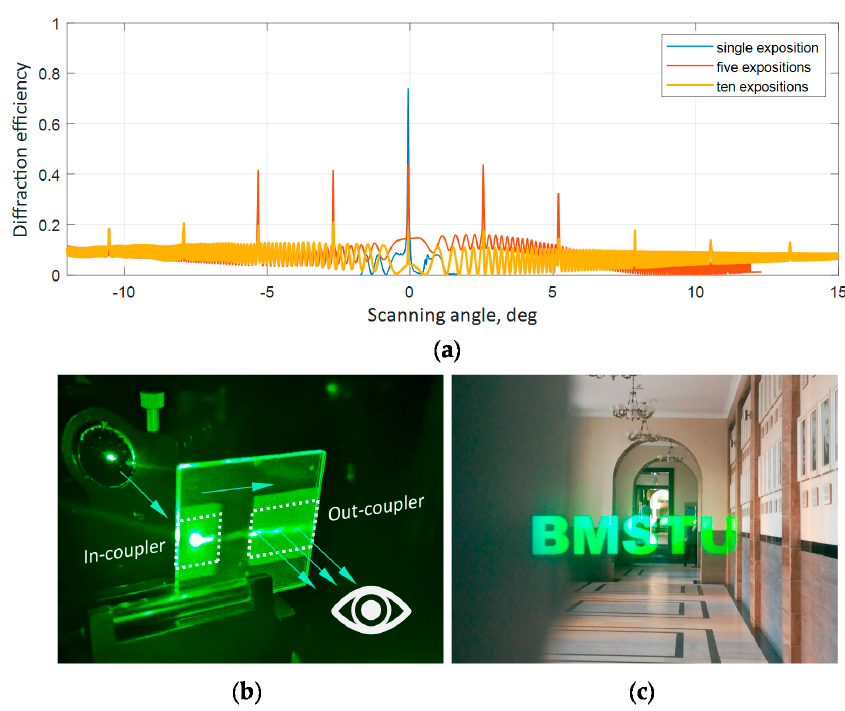
Figure 5. ( a ) Diffraction efficiency via scanning angle recorded with relief phase mask with different Figure multiplexing conditions. ( b ) Illustration of diffraction waveguide work with one inputted substrate-